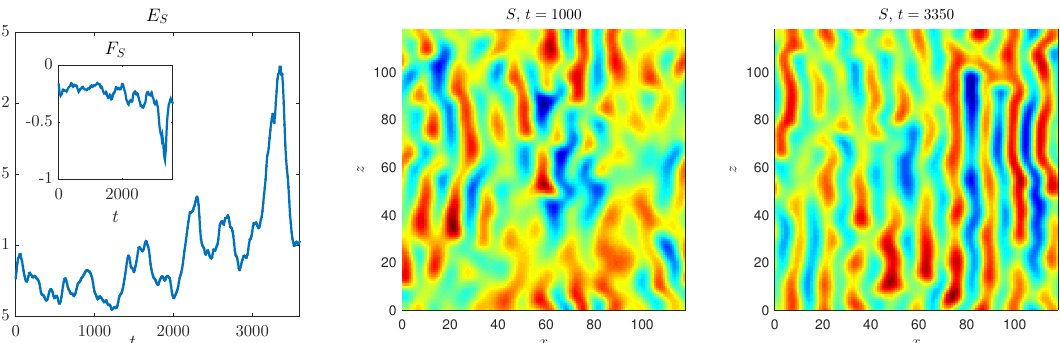
Figure A2. Results from an 8 (cid:96) opt × 8 (cid:96) opt simulation for Ra = 1.1. The left panel shows the time evolution of total energy and vertical salinity flux. The middle and right panels show the instantaneous salinity fields at t = 1000 and 3350,